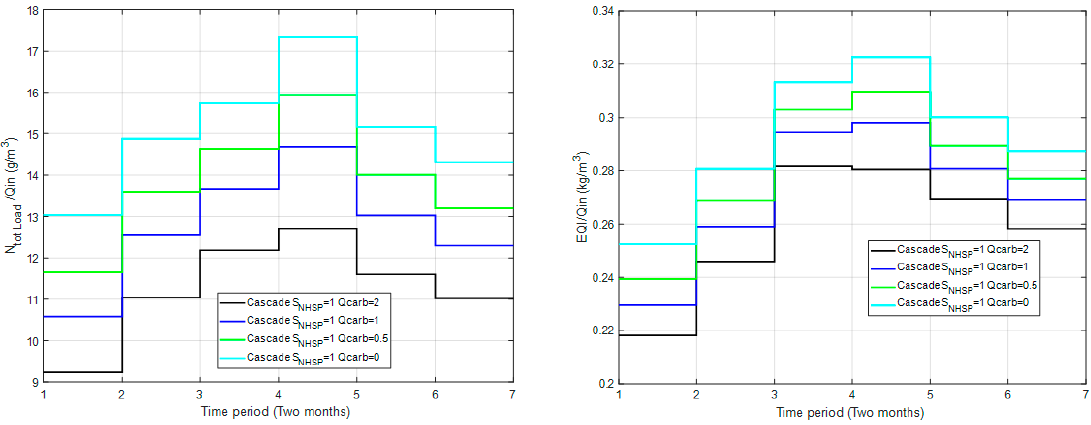
Figure 9. Bimonthly profiles of N tot Load / Q in (g / m 3 ) and EQI / Q in (kg / m 3 ) for Q carb variations under ammonium-based control (Cascade S NHSP ).